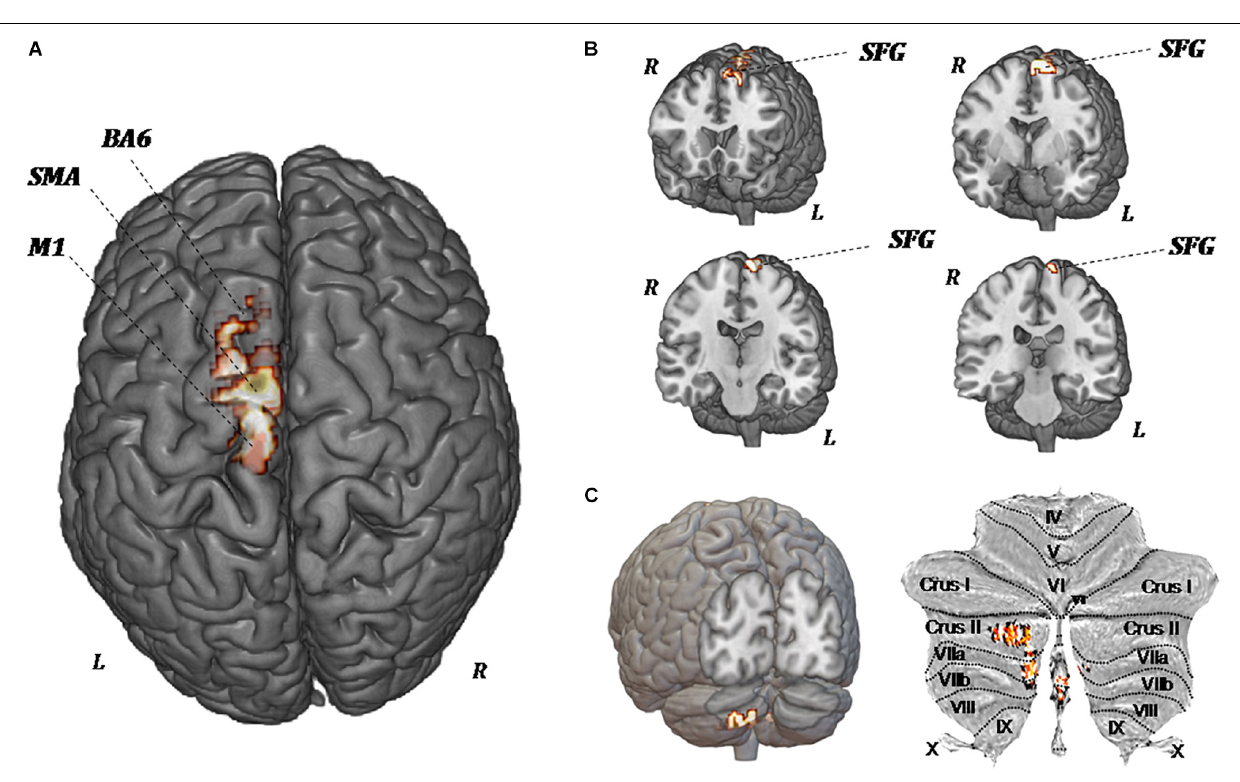
Frontiers in Human Neuroscience |